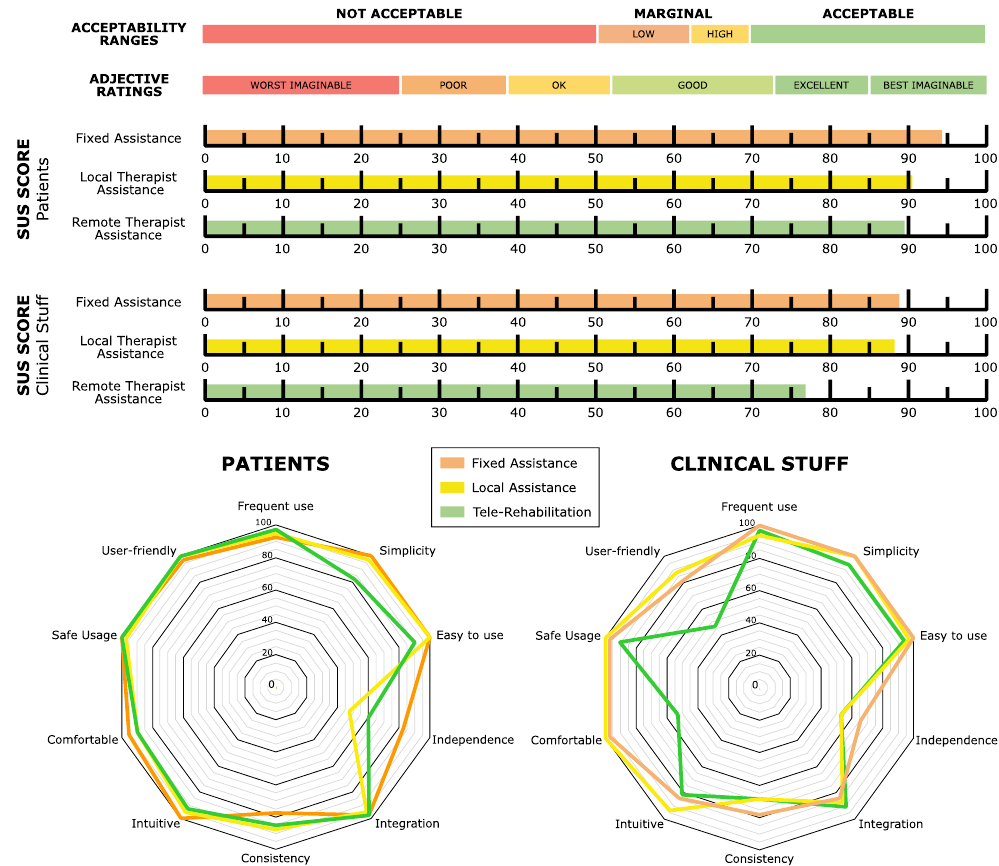
Figure 12. Mean scores of the System Usability Scale (SUS) given by the patients and the clinician